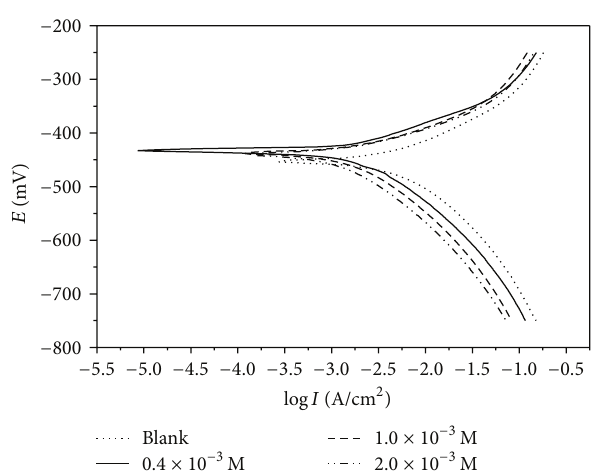
Figure 9: Polarization curves for mild steel in 1N H 2 SO 4 in the absence and presence of different concentration of inhibitor (05).